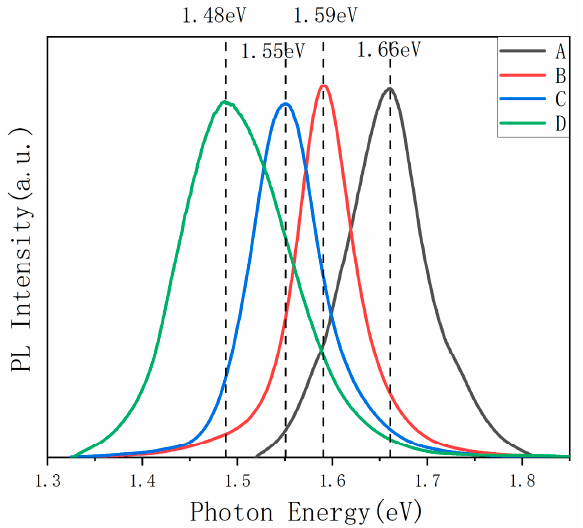
Table 2. The Ga/(In+Ga) measured by ICP and the band gap measured by PL.